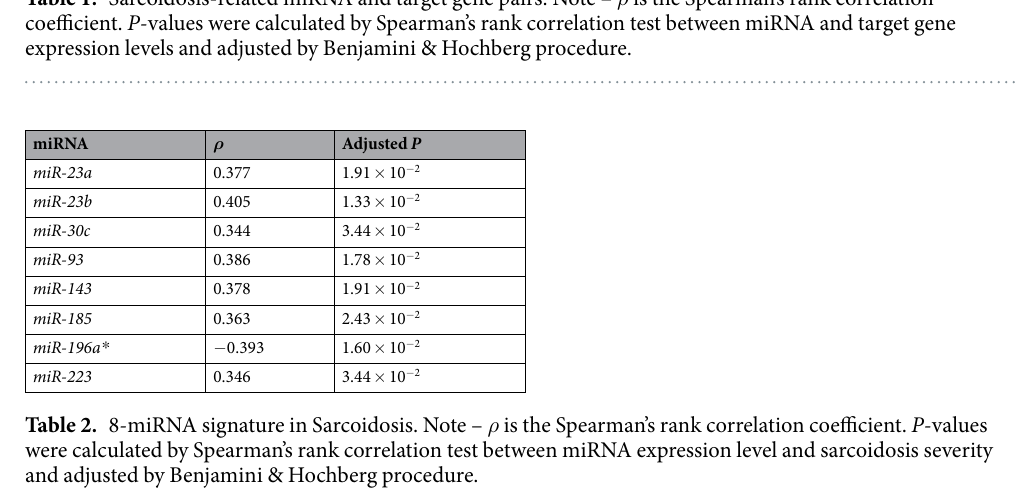
Table 2. 8-miRNA signature in Sarcoidosis. Note – ρ is the Spearman’s rank correlation coefficient. P